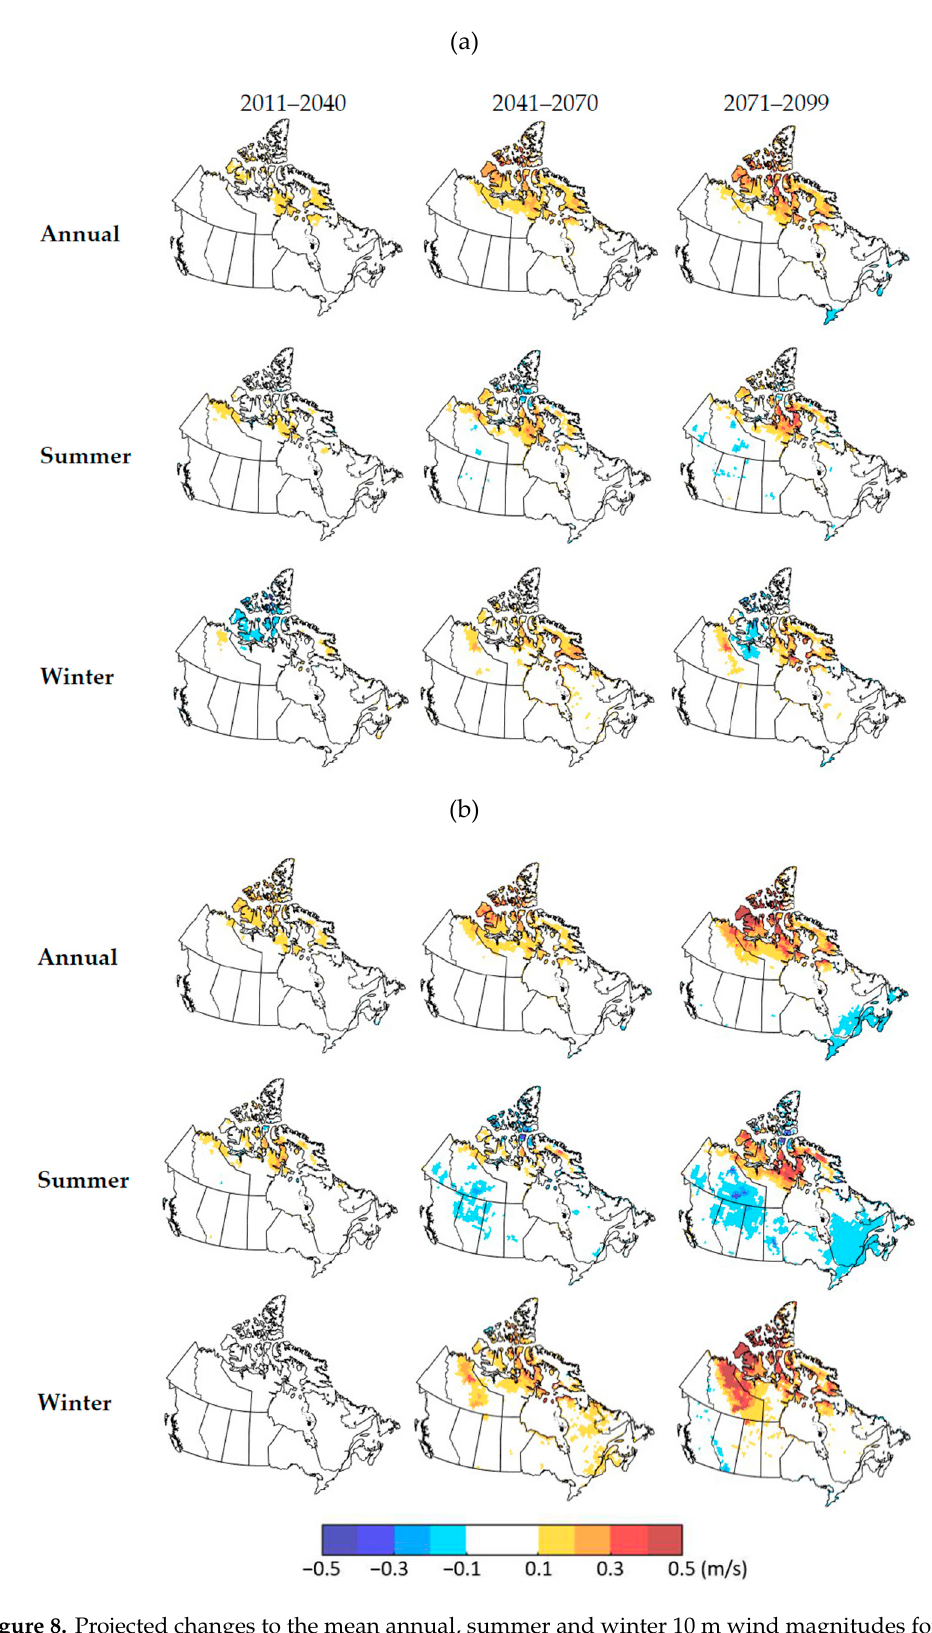
Figure 8. Projected changes to the mean annual, summer and winter 10 m wind magnitudes for the 2011–2040, 2041–2070 and 2071–2100 periods with respect to the current 1981–2010 period for ( a ) RCP 4.5 and ( b ) RCP 8.5